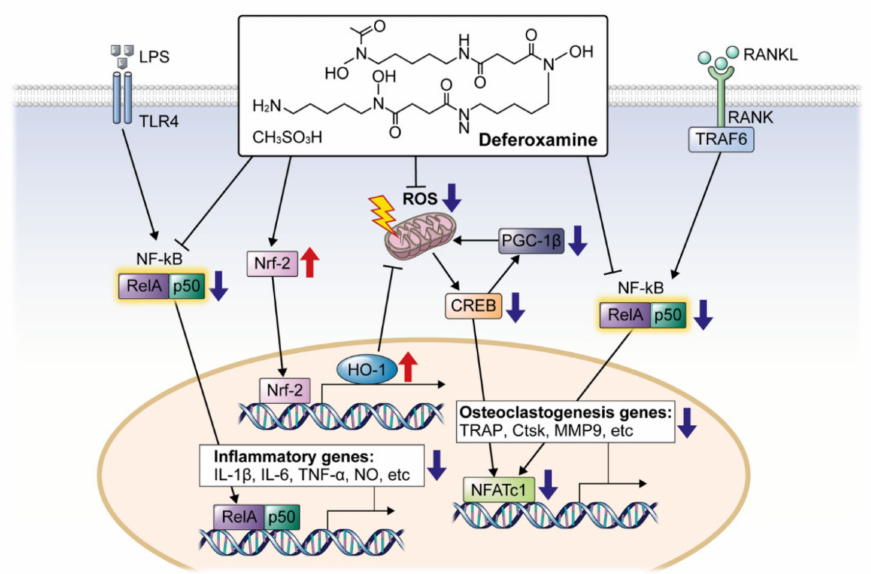
Figure 6. Scheme of a working model for inhibition of inflammation and osteoclast differentiation by DFO in RAW264.7